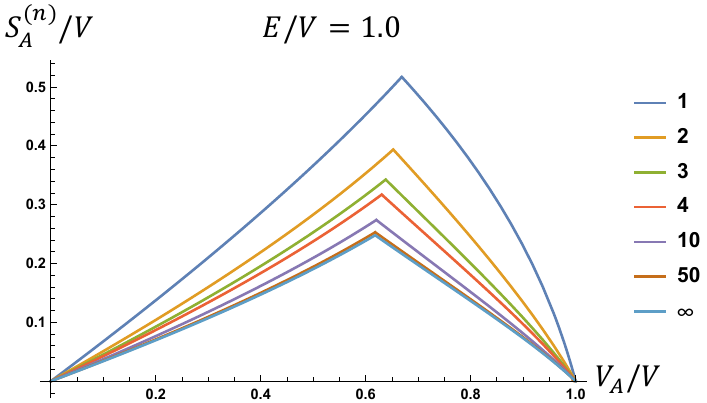
Figure 34 . Renyi and von Neumann entropies as a function of volume fraction for the microcanon- ical ensemble with inhomogeneous entropy densities in A and B